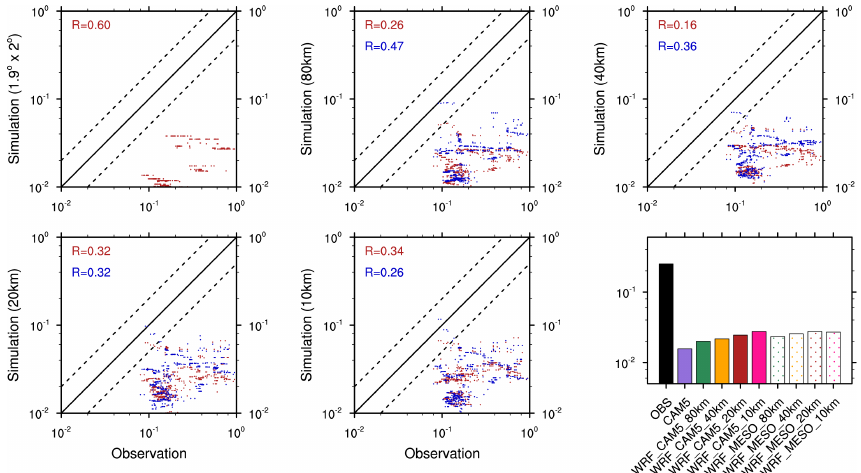
Fig. 11. Scatterplots of aerosol optical thickness from model simulations that utilize the CAM5 (red) and WRF (blue) physics suite, evaluated against AERONET observations at Barrow (71.31 ◦ N, 156.67 ◦ W) and Bonanza Creek (64.74 ◦ N, 148.32 ◦